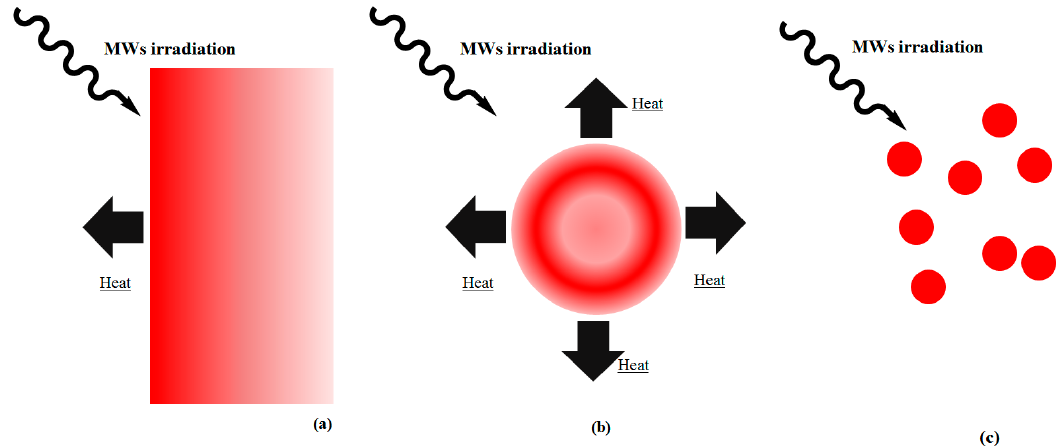
Figure 2. Heat dissipation under MW irradiation considering ( a ) ideal homogenous, ( b ) big and ( c ) small particle-sized MW absorber. Deep colour intensity represents higher temperature regions inside the material.